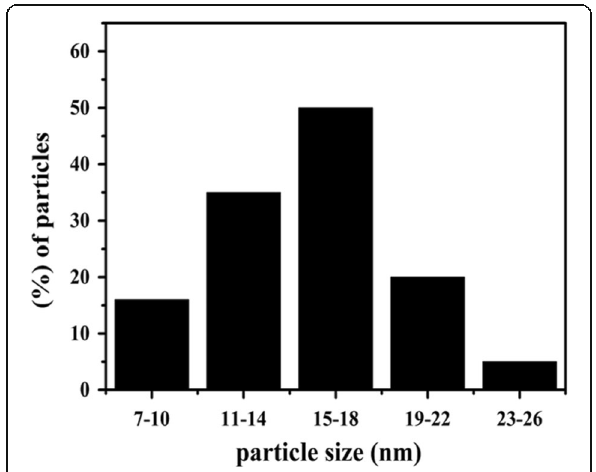
Fig. 9 Plot of ln (A t /A 0 ) against the reaction time